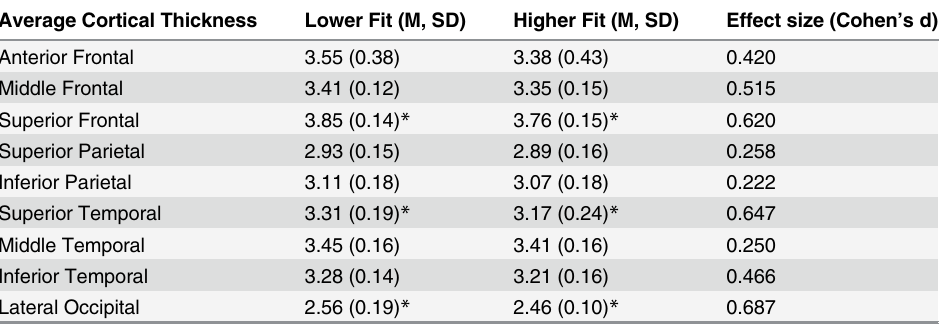
Table 2. Cortical thickness (mean, standard deviation) as a function of aerobic fitness group.